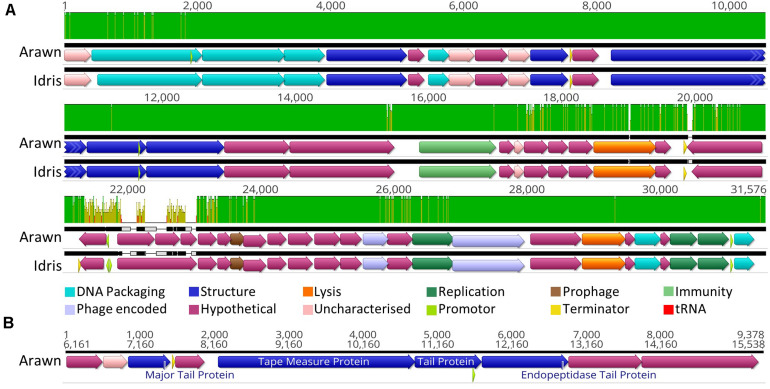
Analysis of the Butyrivibrio phage Arawn and Idris genomes. (A) Mauve alignments (Darling et al., 2004) of the two genomes showing annotated ORFs, with directionality and function according to color. Nucleotide similarity is expressed as a graph, with green indicating 100%, yellow > 30%, red < 30%. (B) The organization of the tail morphogenesis module in phage Arawn. Uncharacterized proteins indicate where the protein was homologous to one reported previously, but had an unknown function, whereas hypothetical proteins did not show similarity above the set thresholds to any known proteins. Phage encoded proteins are those where there was uncertainty about their function.